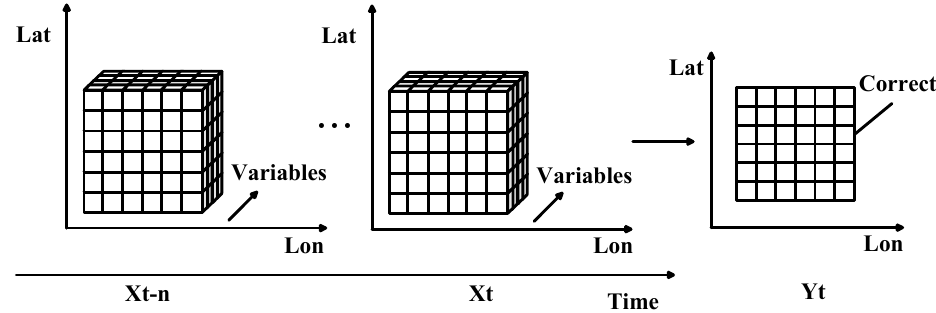
Figure 1. The structure of spatio-temporal variables sequence.